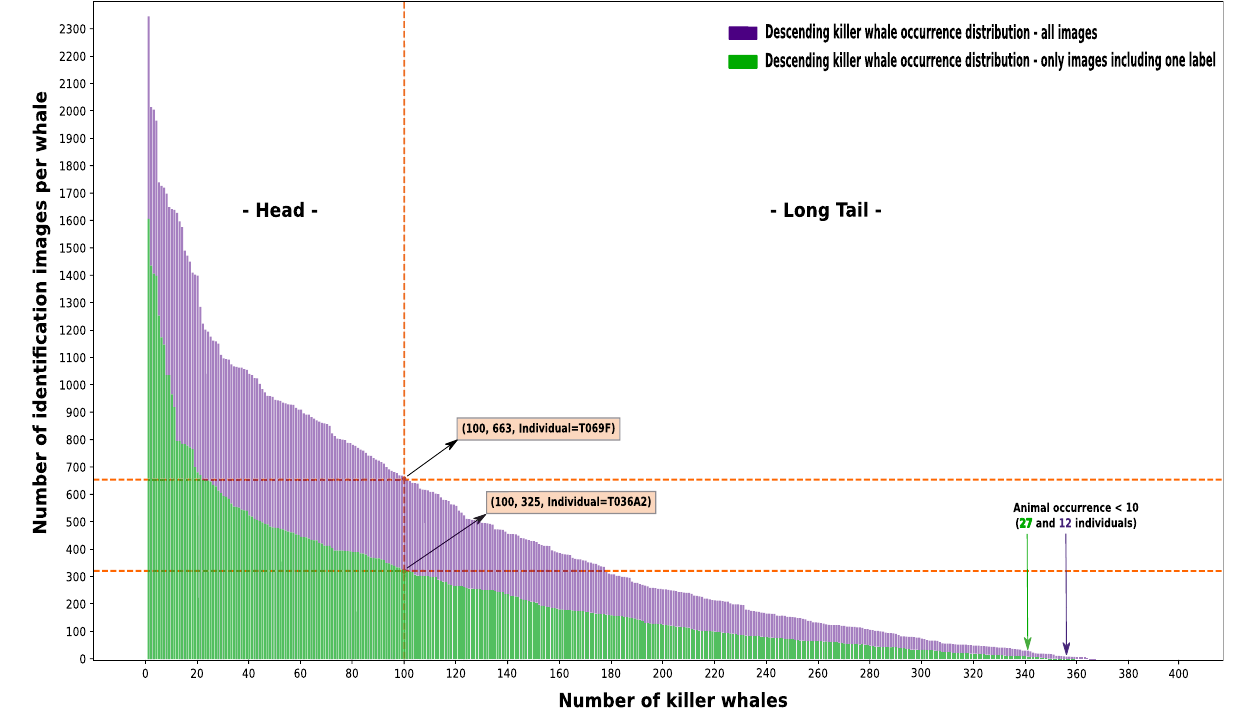
Figure 2. Bigg’s killer whale image long-tailed data distribution (2011–2018), summing up a total of 121,095 identification images, with 86,789 containing single labels, as well as 34,306 photos including multiple labels, resulting in 367 identified individuals (average number of images per individual ≈ 456, standard deviation ≈ 442). The two colored graphs visualize the number of identification images per whale in descending order w.r.t. all images, including single and multiple labels (purple curve) and those only containing a single label (green curve). Furthermore, an exemplary data point is visualized for both curves, presenting the number of identification images in relation to a selected number of whales, here for the top-100, clearly describing the exponential decline. Moreover, the number of animals at which the total amount of identification images is < 10 were marked for both curves. In total, 367 individuals were encountered across 2011–2018. Among them, 128 and 125 were found at least once in each year when considering all images and only those with single labels,